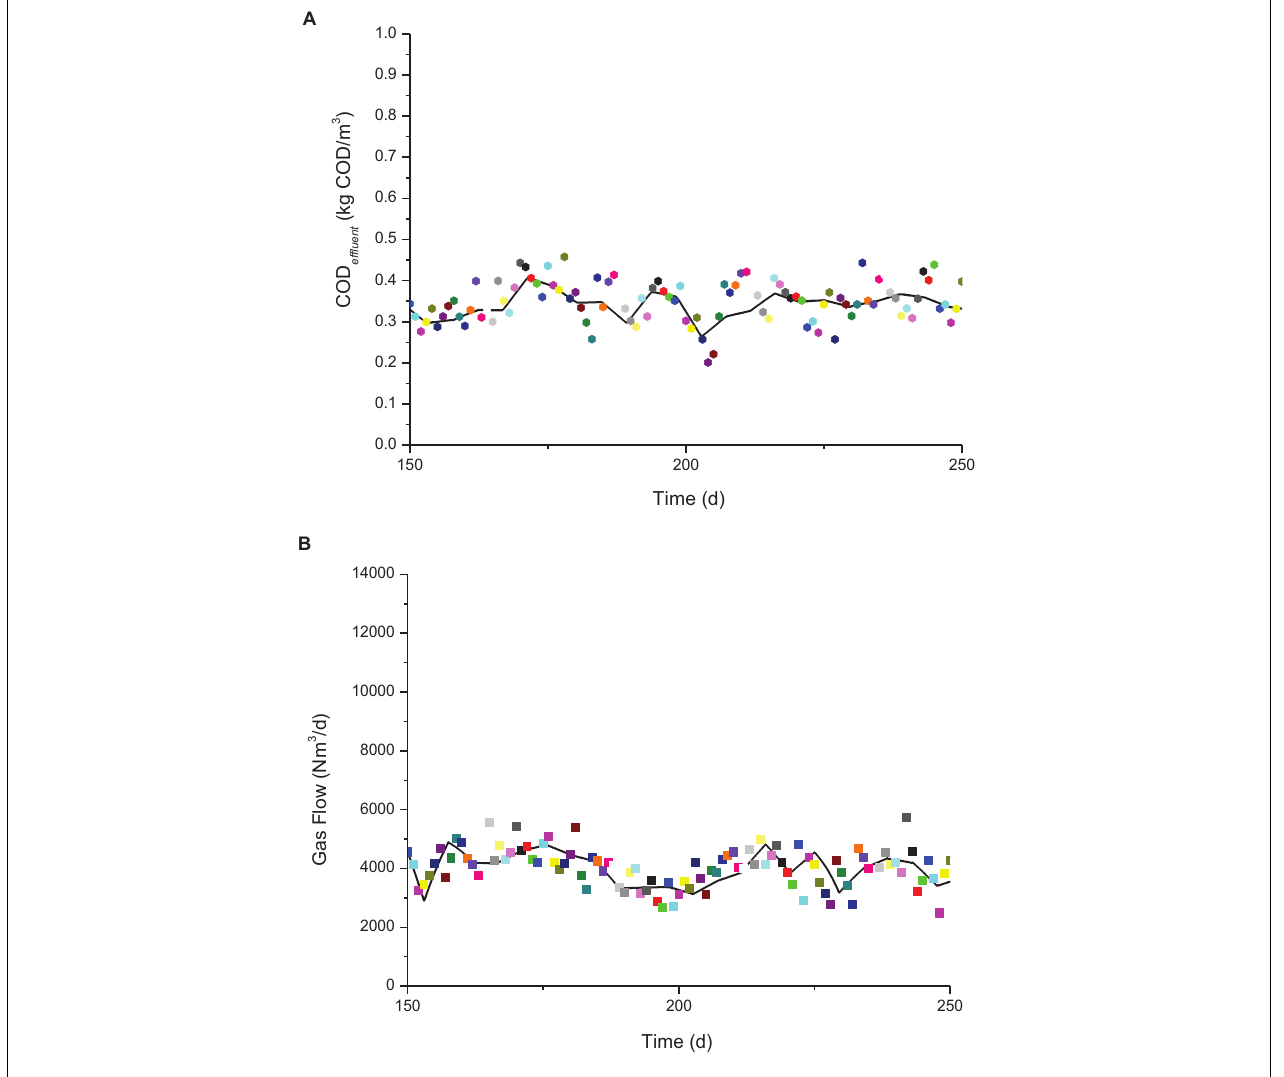
FIGURE 4 | Schematic of simulation result with measured values (color oblique square dot) for IC reactors using subsequent 100-days operation period. (A) Simulation comparison of COD eff . (B) Simulation comparison of biogas production